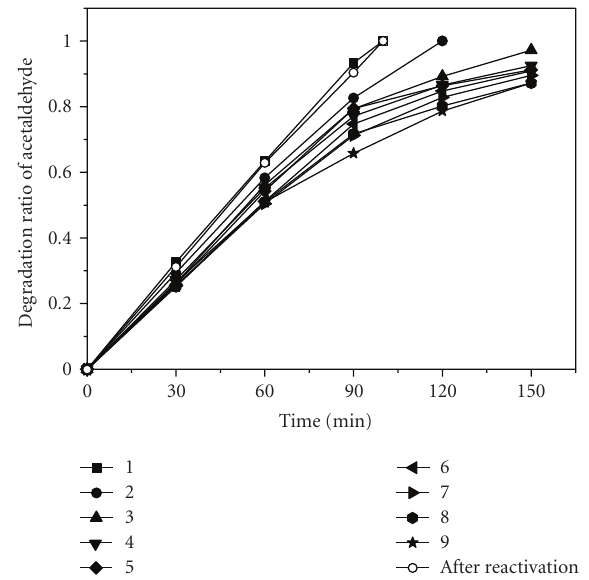
Figure 10: Gaseous acetaldehyde degradation rates on S2T2 for nine consecutive runs and regenerated S2T2 (heating at 300 ◦ C for 1hour) under UV-light irradiation ( λ = 254nm,15W).